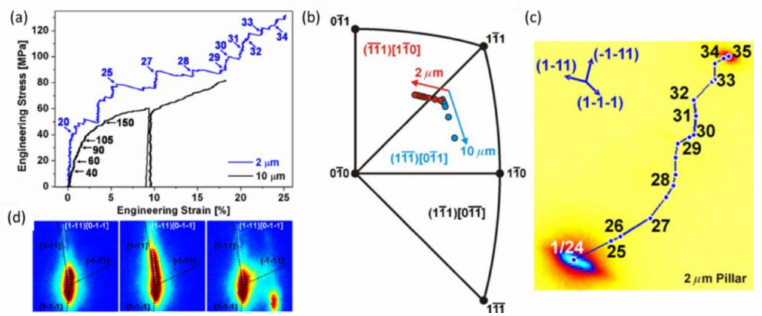
Figure 12. ( a ) Stress-strain curves for an FIB-etched Au micro-pillar during compression. The arrows indicate the corresponding Laue microdiffraction pattern recorded during the mechanical test. ( b ) Inverse pole figure showing the evolution of the real vertical crystalline axis during the compression test. ( c ) Trajectory of the Au Laue peak on the detector, with the same numbering as that indicated in ( a ). ( d ) Intensity distribution of the Laue peak at a load of 0 MPa (#0), 40 MPa (#20) and 77 MPa (#25), respectively [120,127]. Reprinted figure with permission from [120]. Copyright (2007) by the American Physical